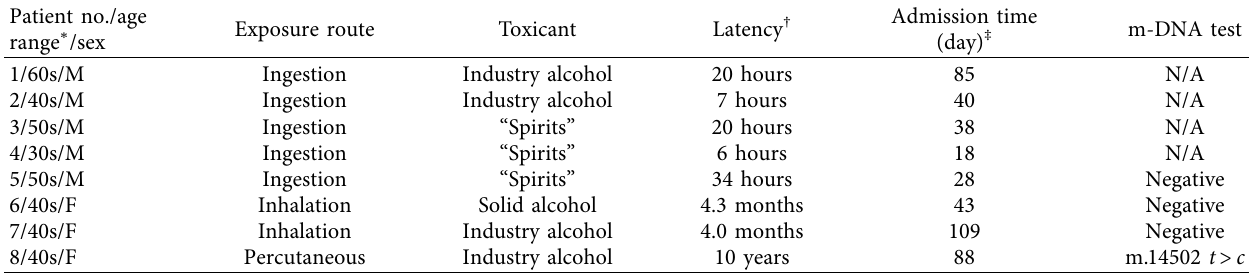
Table 1: Clinical characteristics of eight